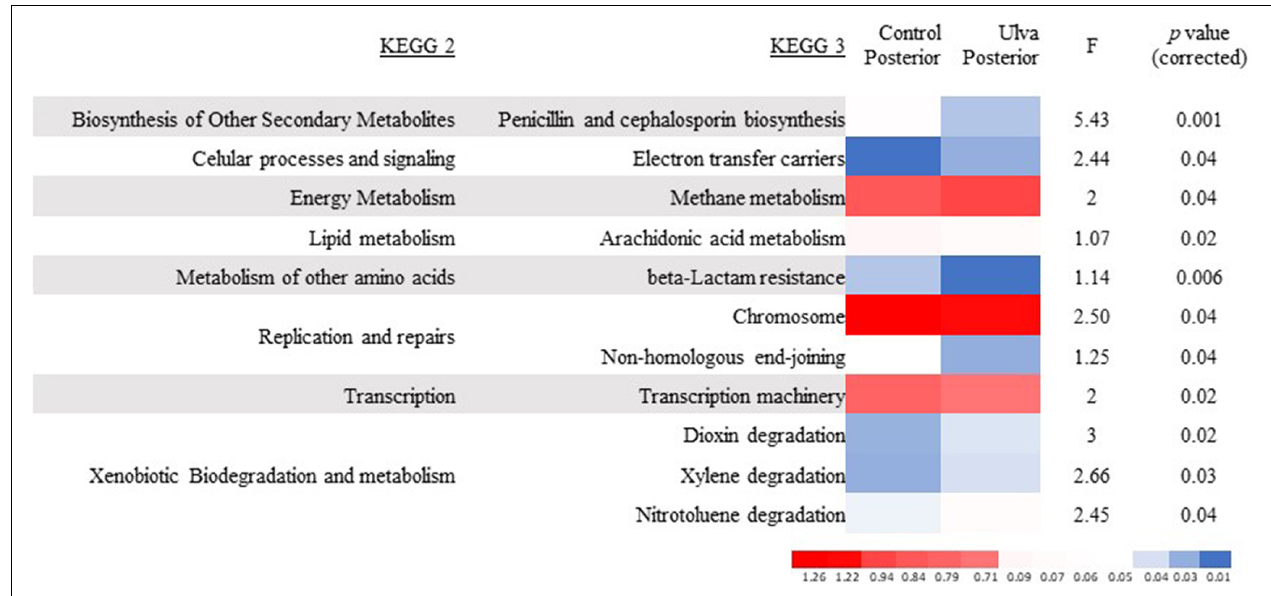
FIGURE 7 | Heatmap showing significant differences (ANOVA, F , p < 0.05) in microbial functionality (PICRUSt) between the posterior intestinal microbiota of S. senegalensis fed control (Control) and U. ohnoi supplemented (Ulva) diet for 90 days. Relative abundance of sequences associated with KEGG functions of the